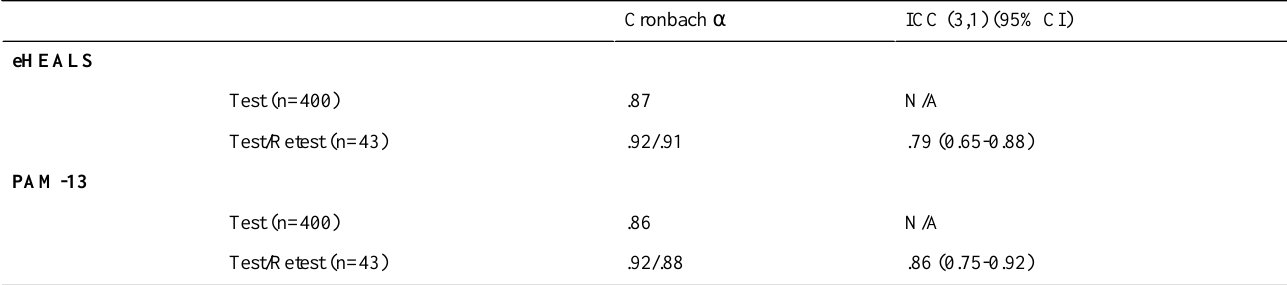
Table 8. Reliability statistics for the PAM-13 and eHEALS.